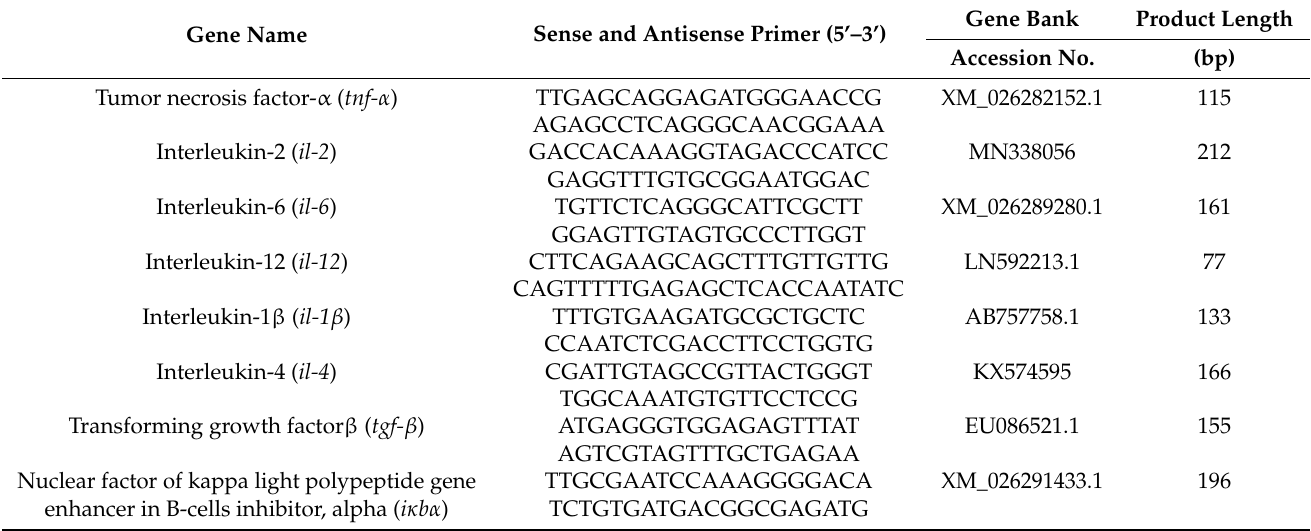
Table 2. Sequences of primers applied for quantitative real-time PCR analysis in gibel